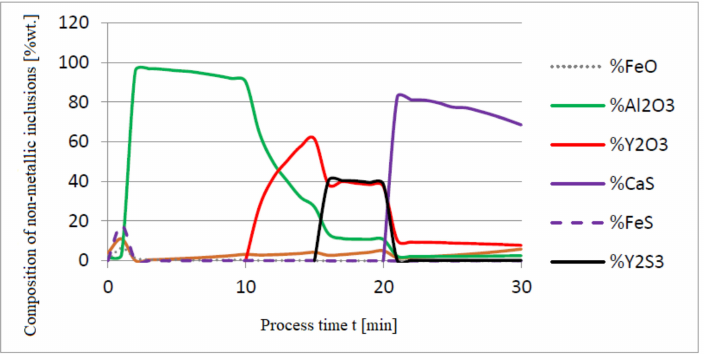
Figure 7. Chemical composition of non-metallic inclusions (wt.%) depending on the process time.